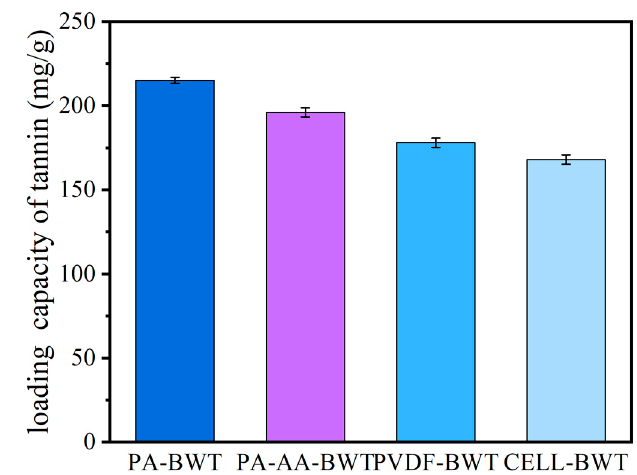
Figure 1. The tannin loading capacity of the tannin-immobilized membranes: PA-BWT, PA-AA-BWT, PVDF-BWT, and CELL-BWT.